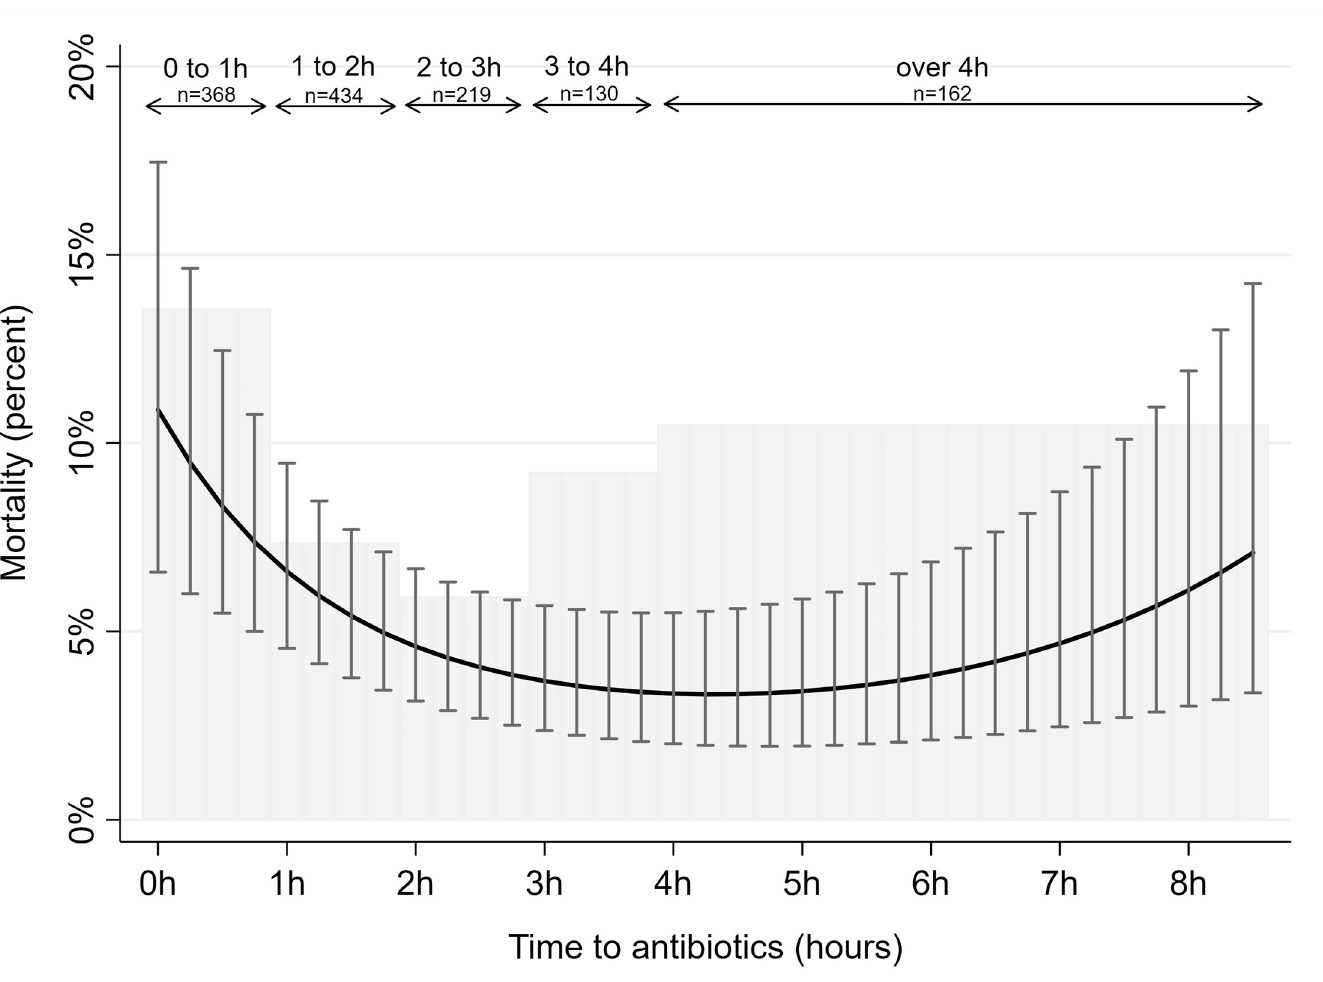
Fig 2. All-cause 30-day mortality by time to antibiotic treatment. Gray shaded histogram represents mortality rates according to time to antibiotic treatment in hours. Solid black curve with bars represents model-predicted mortality rates with 95% confidence intervals according to time to antibiotic treatment in minutes using logistic regression models, adjusted for patient’s age, date of admission, comorbidity, and presence of organ failure. Date of admission was measured using calendar days since study start, entered as a polynomial function with first (b -0.011 p < 0.001), second (b 2.5e-5 p < 0.001) and third degree (b -1.2e-8 p < 0.01) variables. The model prediction uses average values for adjustment